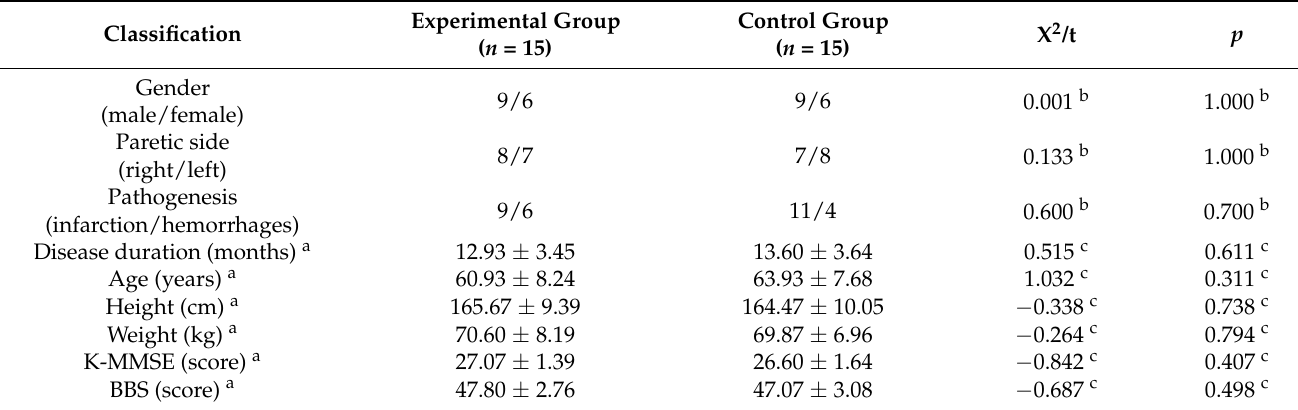
Table 2. General characteristics of the participants.